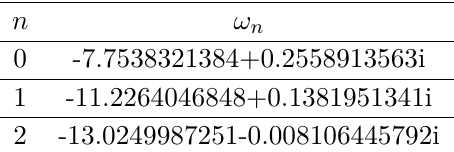
(blue line) and ψ (yellow line) of the scalar field for Q = 2 (0) (1)